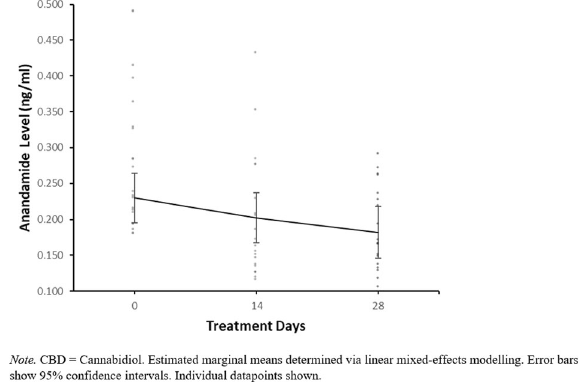
Fig. 4 Estimated marginal means of anandamide levels in the placebo group by week.